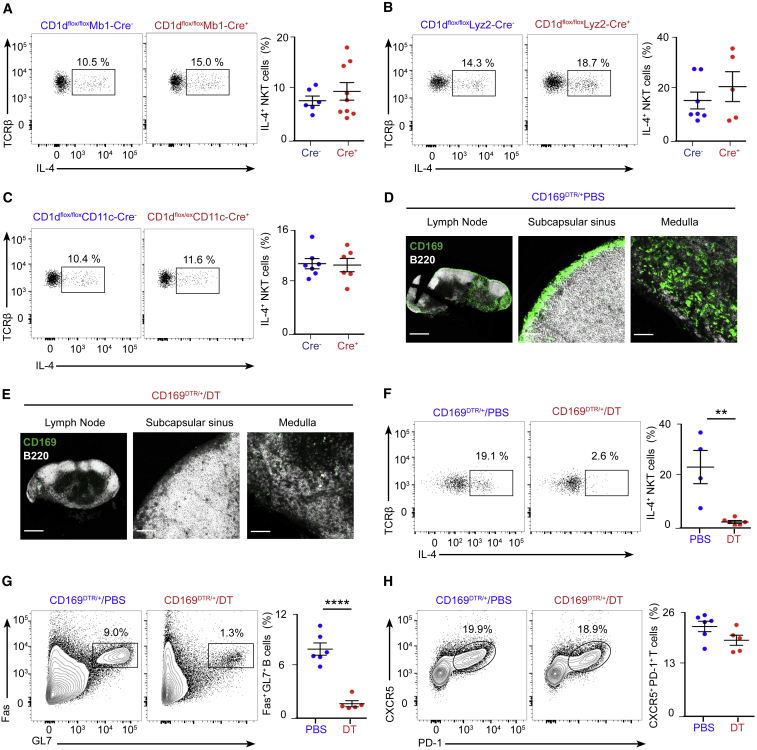
Resident Macrophages Promote Early IL-4 Production by NKT Cells and Antiviral B Cell Immunity(A–C) Flow cytometry analysis of IL-4 production by NKT cells in (A) CD1dflox/floxMb1-Cre, (B) CD1dflox/floxLyz2-Cre, and (C) CD1dflox/exCD11c-Cre mice on day 3 of influenza infection: Cre− (blue dots) and Cre+ (red dots).(D and E) Confocal microscopy analysis of CD169DTR/+ mice after 4 days of (D) PBS or (E) diphtheria toxin (DT) administration. Sections were stained with antibodies to B220 (white) and CD169 (green). Scale bars, 300 μm (left) and 60 μm (center and right).(F) Flow cytometry analysis of IL-4 production by NKT cells from CD169DTR/+/PBS-treated or CD169DTR/+/DT-treated mice on day 3 of influenza infection: PBS (blue dots) and DT (red dots).(G and H) Flow cytometry analysis of germinal center (G) and TfH (H) cells in CD169DTR/+/PBS-treated and CD169DTR/+/DT-treated mice on day 9 of influenza infection: PBS (blue dots) and DT (red dots).In all panels, each dot represents one mouse. Data show one representative result from three experiments. Data represent mean ± SEM; two-tailed paired Student’s t test, ∗∗p < 0.01, ∗∗∗∗p < 0.0001.